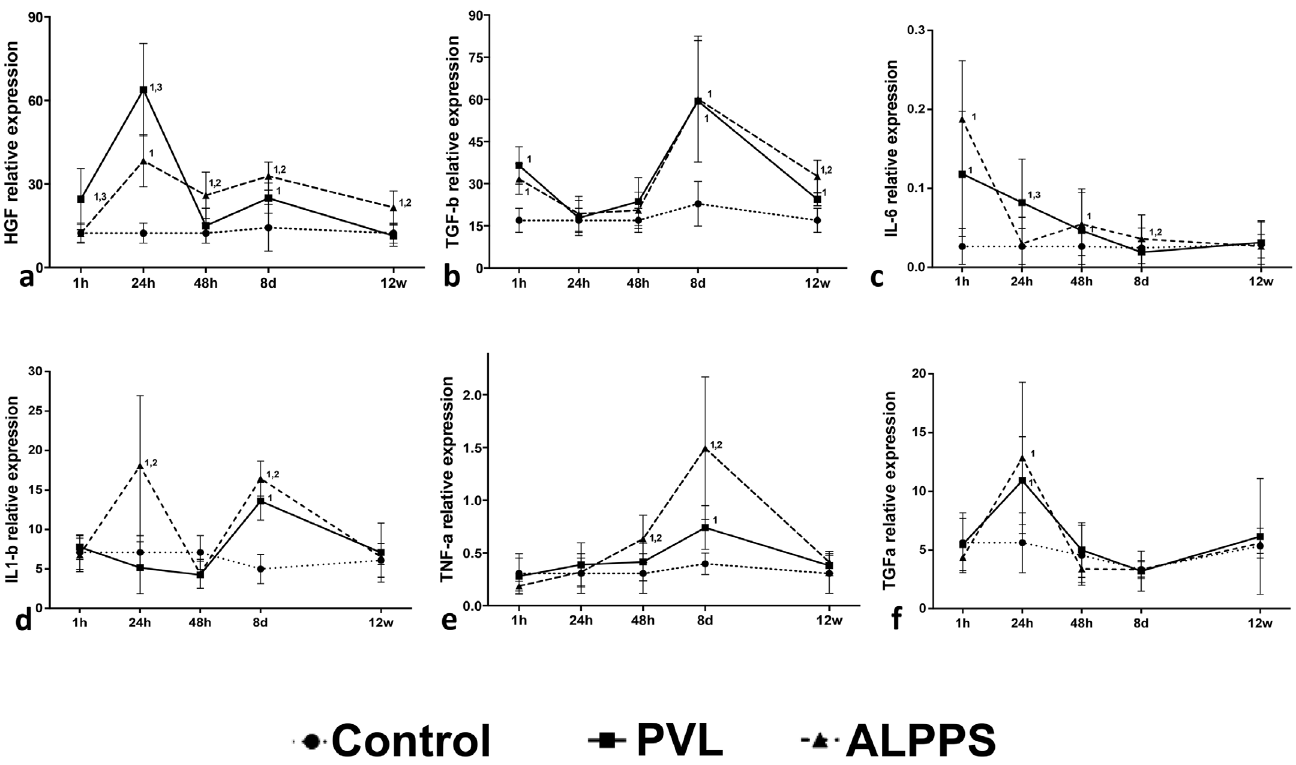
Fig 5. Relative expression of mRNA of (a) HGF, (b) TGF- β , (c) IL-6, (d) IL1- β , (e) TNF- α and (f) TGF- α at 1, 24, 48 hours, 8 days and 12 weeks in controls, PVL and in ALPPS FLR. Mann-Whitney U-test (n = 6 animals per group). The numbers (1, 2, 3) indicate significant differences of the considered group in comparison with control (1), PVL (2) and ALPPS (3) groups, respectively. A p value of < 0.05 was considered as